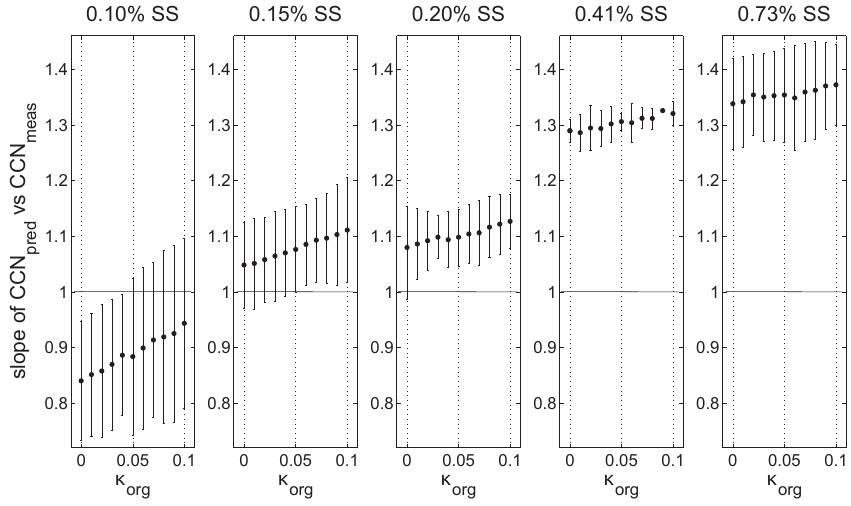
Fig. 5. The slope of CCN pred vs. CCN meas for permutation 13 ( κ sulf = 0 . 61, ρ org = 1gcm − 3 ), varying κ org between 0 and 0.1.